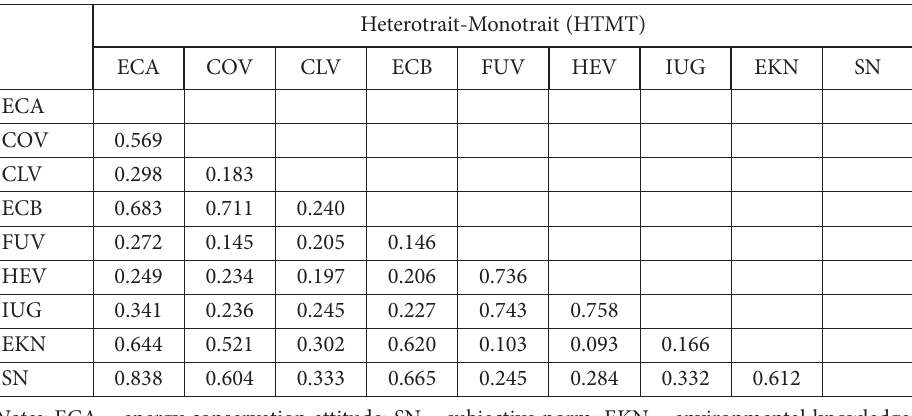
Table 3. Discriminant